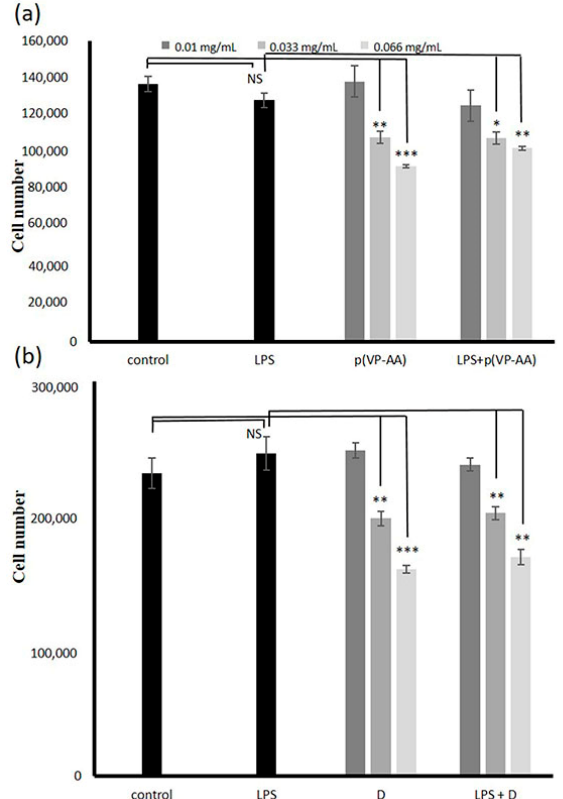
Figure 4. Effect of p(VP-AA) and DNPs on the viability of basal and activated HMEC-1 cells. ( a ) Concentration-dependent effect of p(VP-AA) NPs on HMEC-1 cells’ viability. Basal state and exposed to LPS cells were cultured in 96-well plates and treated with p(VP-AA) NPs for 48 h; ( b ) Concentration-dependent effect of DNPs (D) on HMEC-1 cells’ viability. Basal state and exposed to LPS cells were cultured in 96-well plates and treated with DNPs for 48 h. The results represent the average of three separate experiments. Statistical significance: * p ≤ 0.05,** p ≤ 0.01, *** p ≤ 0.001, NS = not significant compared to respective controls.